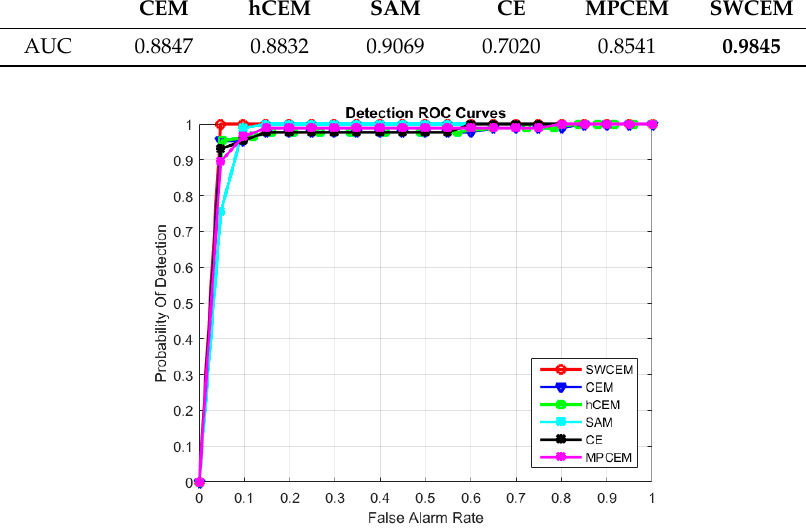
Figure 14. ROC curves of different methods on AVIRIS Dataset 1.